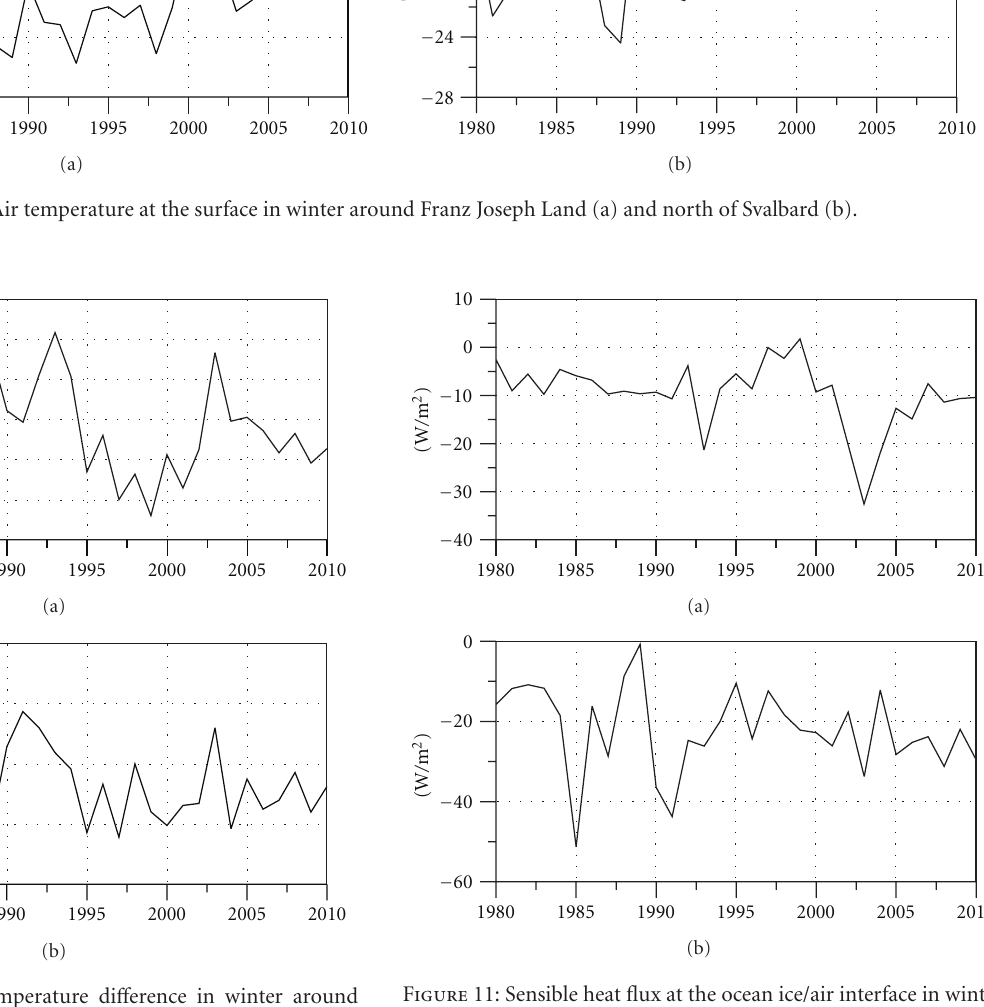
Figure 10: Surface-air temperature di ff erence in winter around Franz Joseph Land (a) and north of Svalbard (b).